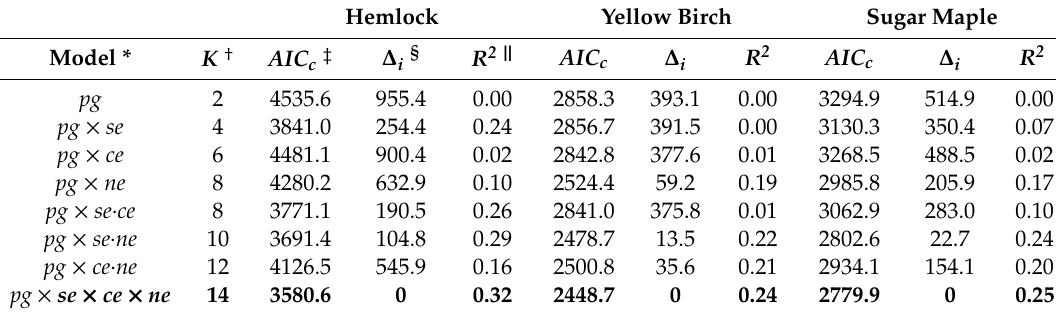
Table 2. Statistics for models of radial growth of three northern hardwood tree species in an old- growth hemlock forest in east–central New York, United States of America (USA); the best model for each species (in bold) incorporates neighborhood competition, target tree size, and climate.